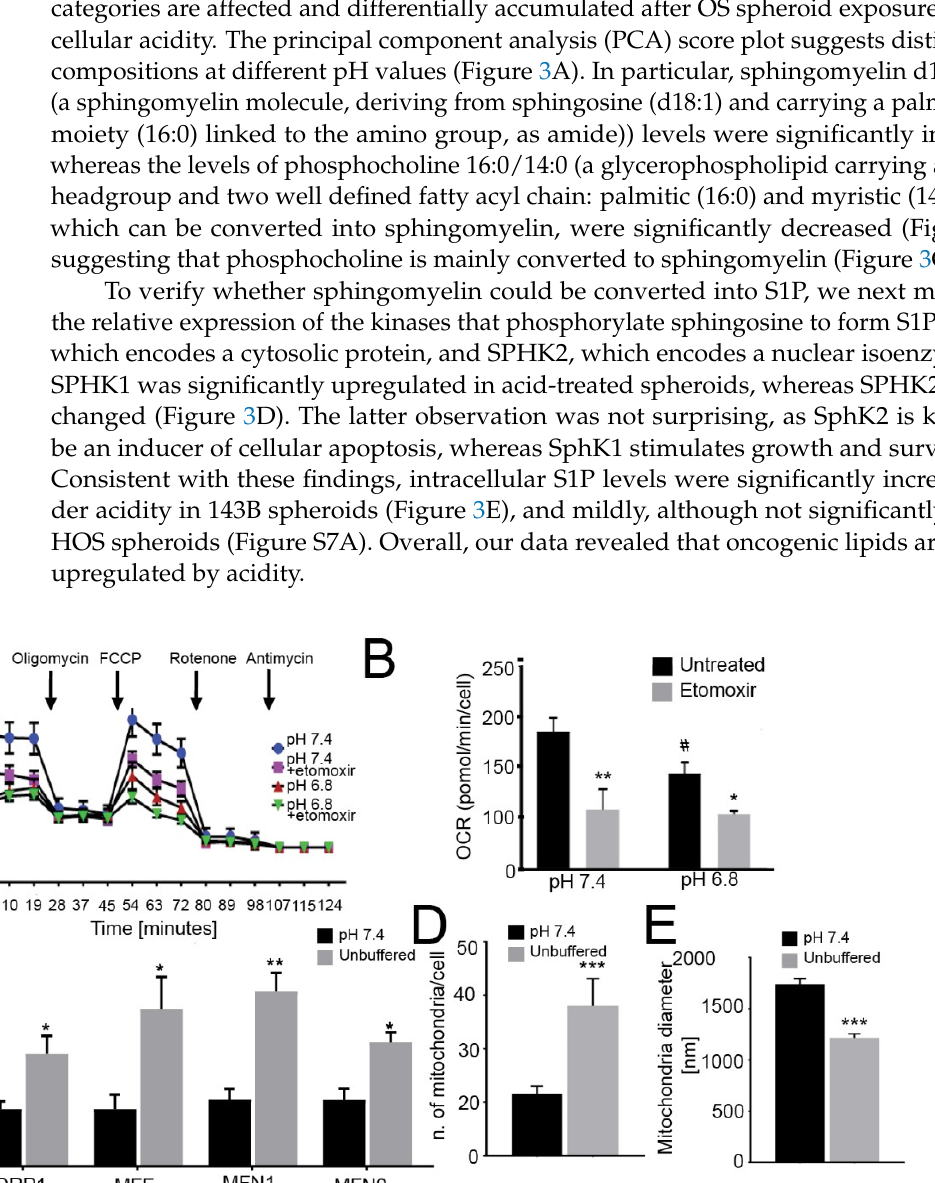
Figure 2. Mitochondria have low oxygen consumption and β -oxidation rates and relocalize to perinuclear regions under acidity. ( A ) OCR of monolayer 143B tumor cells chronically adapted to acidosis expressed as pmol O 2 /min normalized to protein content under basal conditions and after the injection of oligomycin, carbonyl cyanide 4-(trifluoromethoxy) phenylhydrazone (FCCP), rotenone or antimycin A. Graph shows OCR after antimycin A subtraction, to ensure removal of non-mitochondrial oxygen consumption. To evaluate β -oxidation of intracellular pool of fatty acids, 40 μ M etomoxir